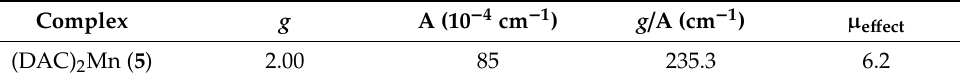
Table 5. EPR spectral data of complex (DAC) 2 Mn in DMSO.